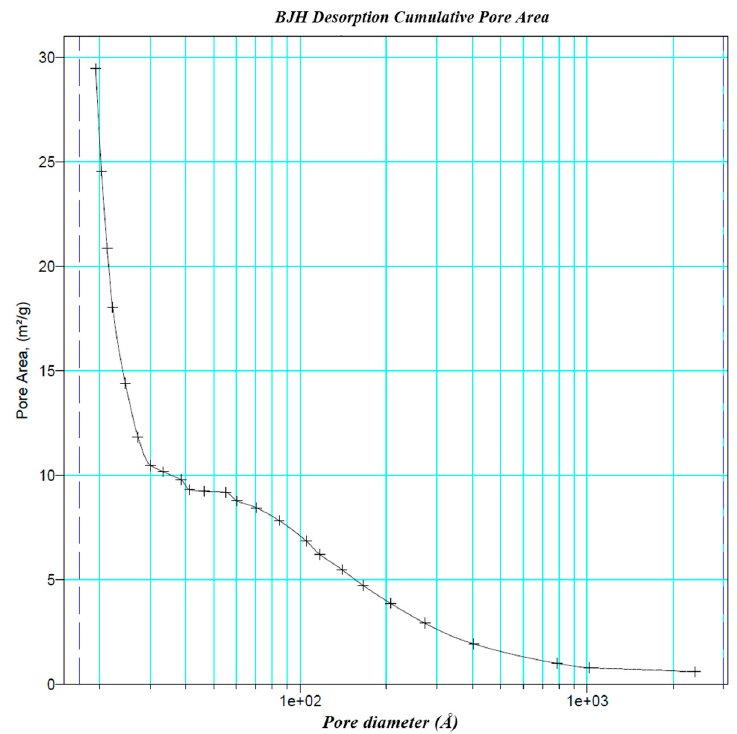
Figure 5. BJH adsorption cumulative pore area distribution of zeolite JLOX101-LiX.